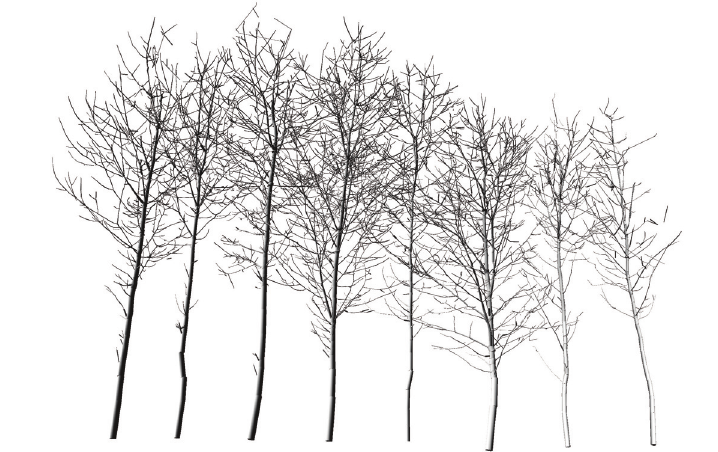
Figure 3. Visualization of eight neighboring Group III tree